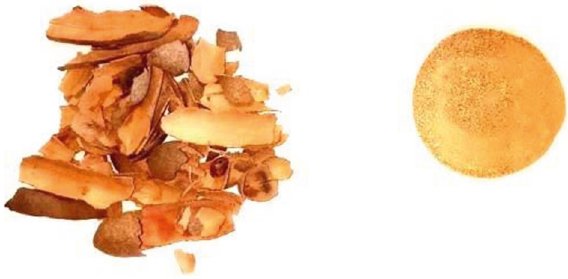
Figure 1: Tamarind fruit